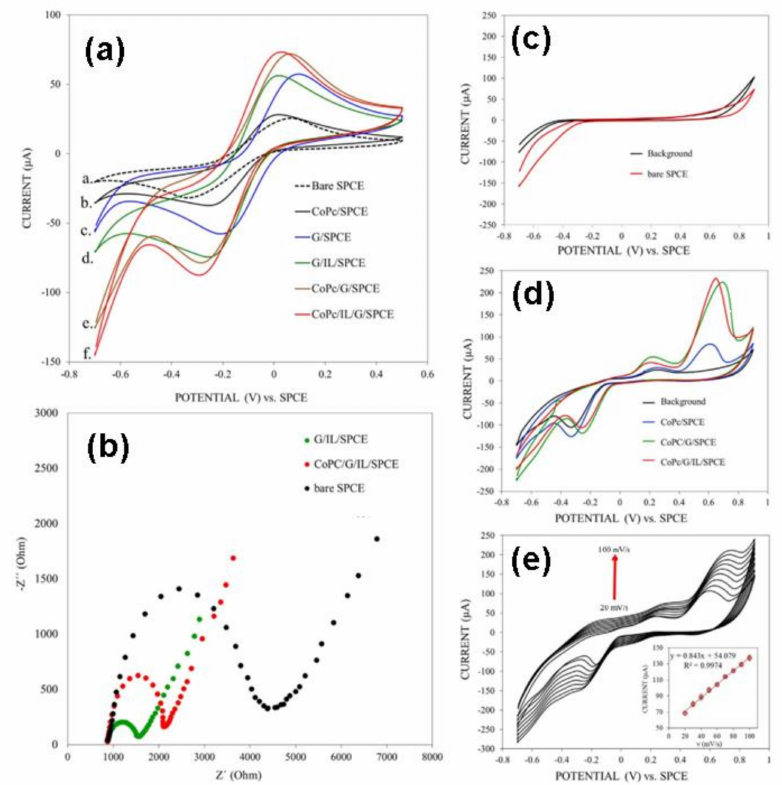
Figure 4. ( a ) CV characterization of diverse electrodes in presence of [Fe(CN)6] 3 − . ( b ) EIS of un- modified SPCE (black), CoPc/IL/SPCE (green), and CoPC/G/IL/SPCE. ( c ) CV of the unmodified electrode in the absence or presence of glucose. ( d ) The electrochemical response of the diverse elec- trodes in presence of 2.0 mM glucose at 0.5 Vs − 1 . ( e ) The effect of the scan rate on CoPC/G/IL/SPCE over glucose oxidation. Redrawn with permission of Elsevier from Reference